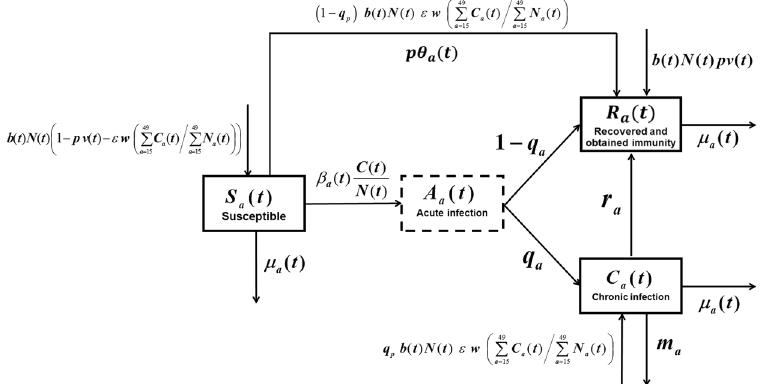
Figure 1. Flow chart of HBV transmission. Here “ a ” denoted the age and “ t ” denoted the time. β a ( t ) denoted the average transmission rate in age group a in year t in the sense that an age a susceptible had contacted with an infectious individual and was successfully infected; q a denoted the age-specific proportion of acute HBV infections that became chronic per year; r a denoted the annual rate of HBsAg seroclearance in chronic HBV infections; m a denoted the age-specific mortality rate of HBV-related diseases per year; θ a ( t ) denoted catch-up vaccination coverage rate for population aged 8–15 years in 2009–2011; μ a ( t ) denoted age- and time-dependent death rate of non-HBV related diseases in year t ; b ( t ) denoted birth rate in year t ; v ( t ) denoted vaccination coverage rate of newborns in year t ; p denoted vaccination protection rate per year; ε denoted perinatal infection rate per year; w denoted the proportion of HBsAg positive mothers in the total prevalence of HBsAg aged 15–49 years; q p denoted the proportion of acute HBV infections that became chronic during delivery; N ( t ) denoted the total number of population in year t ; C ( t ) denoted the total population number of chronic HBV infections in year t ; N a ( t ) denoted the number of people in age category a in year t